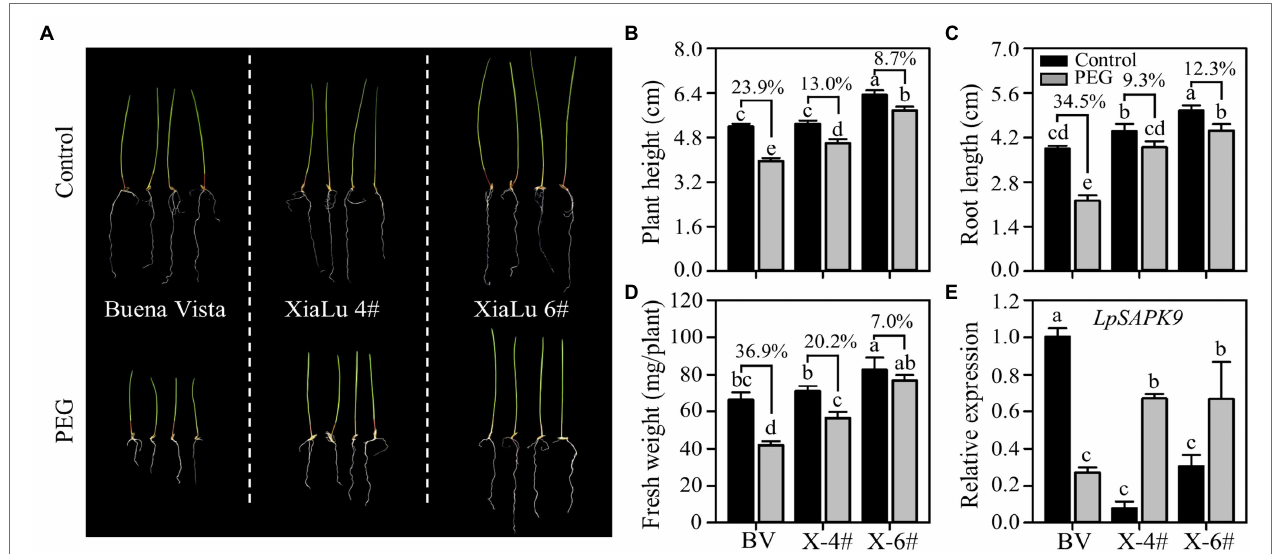
FIGURE 9 | Expression of LpSAPK9 to drought stress in three perennial ryegrass cultivars differing in drought tolerance. (A) The phenotype of three perennial ryegrass cultivars under control and drought stress conditions. (B–D) Growth traits (e.g., plant height, root length, and above-ground biomass) of three perennial ryegrass cultivars under control and drought stress conditions. “BV” and “X” in (D) represent “Buena Vista” and “XiaLu.” (E) Expression levels of LpSAPK9 of three perennial ryegrass cultivars under control and drought stress conditions. Data are means ± SE ( n = 4). Different letters above bars represent significant differences at p ≤